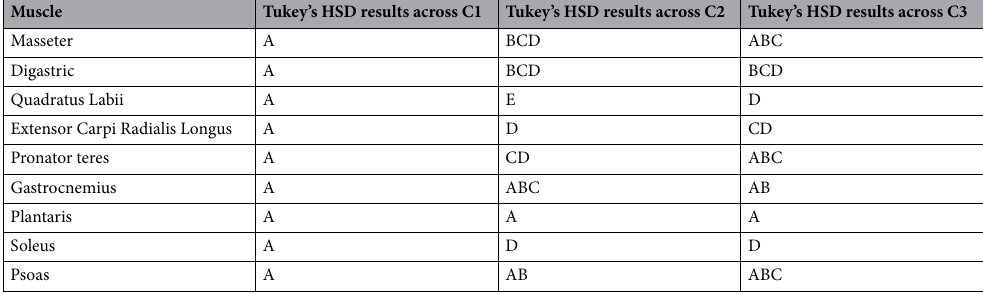
Table 3. “Connected Letter” report of Tukey’s HSD results of density differences between the anatomical regions of each age-cohort (C1 = 3 weeks old; C2 = 8 months old; C3 = 2 years old). Muscles connected by letters cannot be statistically separated at α = 0.05. For example, the density of gastrocnemius, plantaris and psoas cannot be distinguished across any of the three age-cohorts (all connected by the letter “A”, as are all of the muscles of the density indistinct youngest cohort), but the density of soleus is significantly different (connected to other muscles labeled “D”, but without a connection to “A”) than that of gastrocnemius in the two older